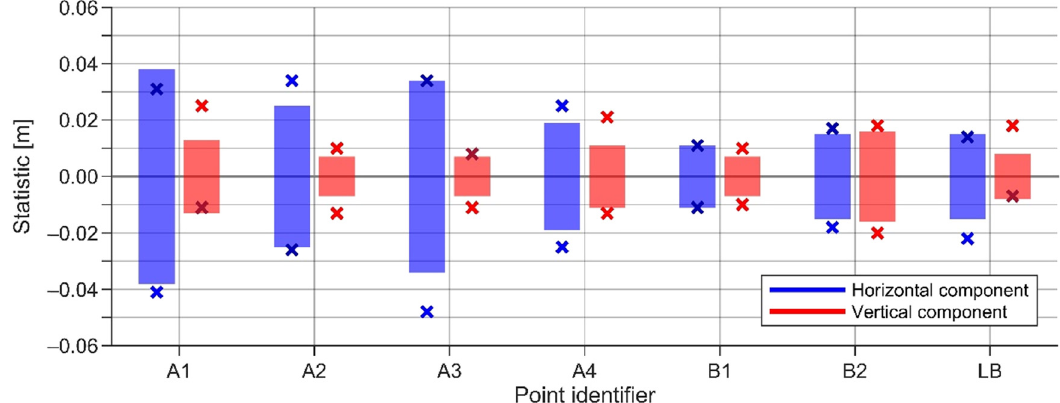
Figure 4: Statistical properties ( with respect to mean values ) of the total station measured coordinate components. The colored bars denote standard deviation estimates, whereby minimum and maximum coordinate component di ff erences are shown with